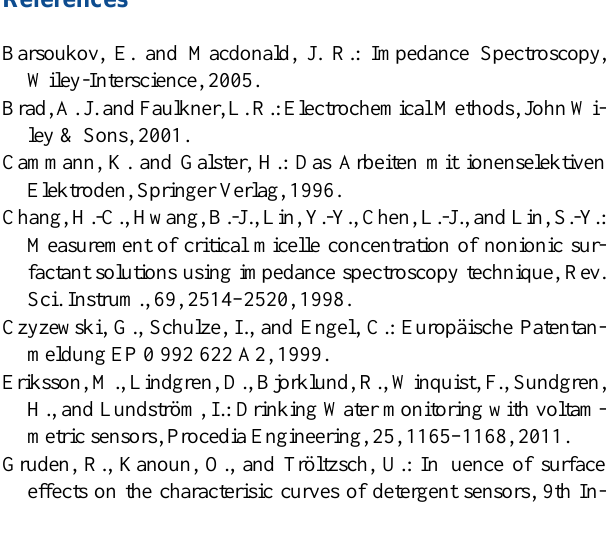
Figure 12. Dependence of the IS on detergent concentration.